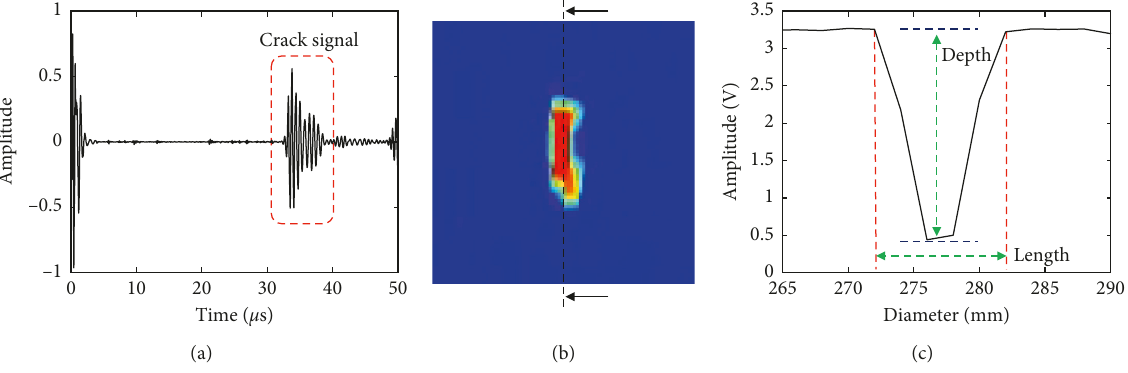
Figure 13: Inspection results for standard-type crack: (a) A-scan, (b) C-scan, and (c) cross section amplitude.